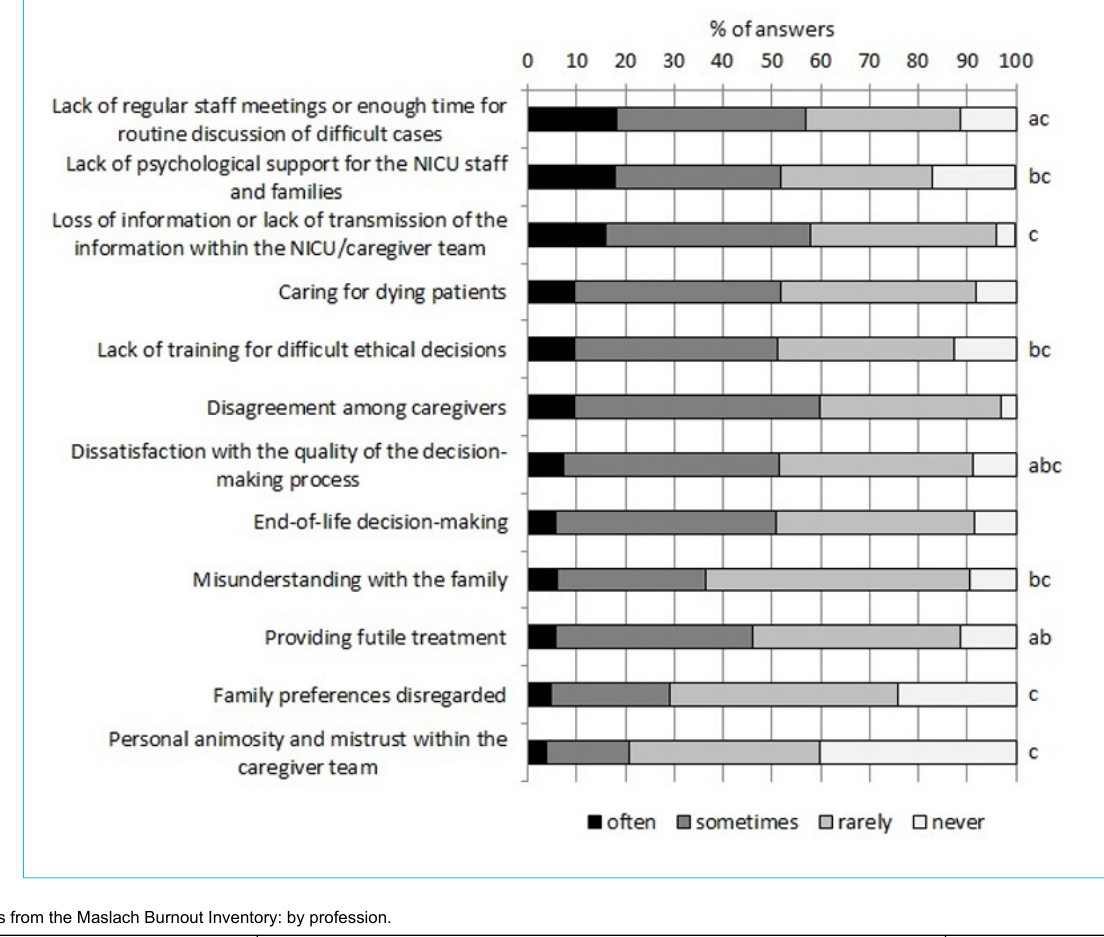
Figure 1: Answers to the question about how often aspects of work are a source of distress (n = 397). a statistically significant difference be- tween physicians and nurses (Mann-Whitney U test). Nurses rated these items as more common than physicians. b statistically significant dif- ference between length of experience (≤5 years, 6–15 years, >15 years, Kruskal-Wallis test). Items were less commonly reported with increas- ing work experience. c statistically significant difference between German and French speaking part of Switzerland (Mann-Whitney U test).